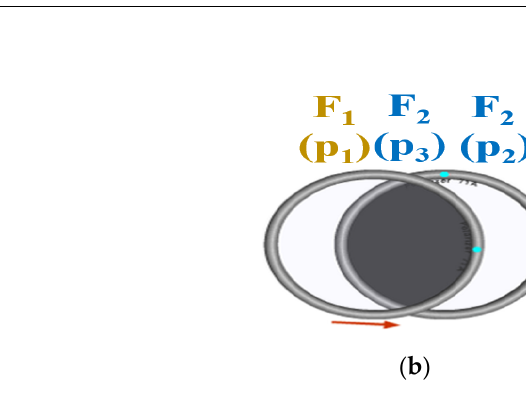
Figure 9. Adjustment of rotation angle using a filter. ( a ) LPF configuration. ( b ) Combination of LPF. When F 1 is fixed and the rotation direction angle (r 1 ) is 0° as shown in Figure 10, V in and H in incident on the filter have vertical and horizontal polarization at P 0 , respectively. At this point, when V in and H in pass through F 1 , both V in and H in change to horizontal polarization at P 1 .